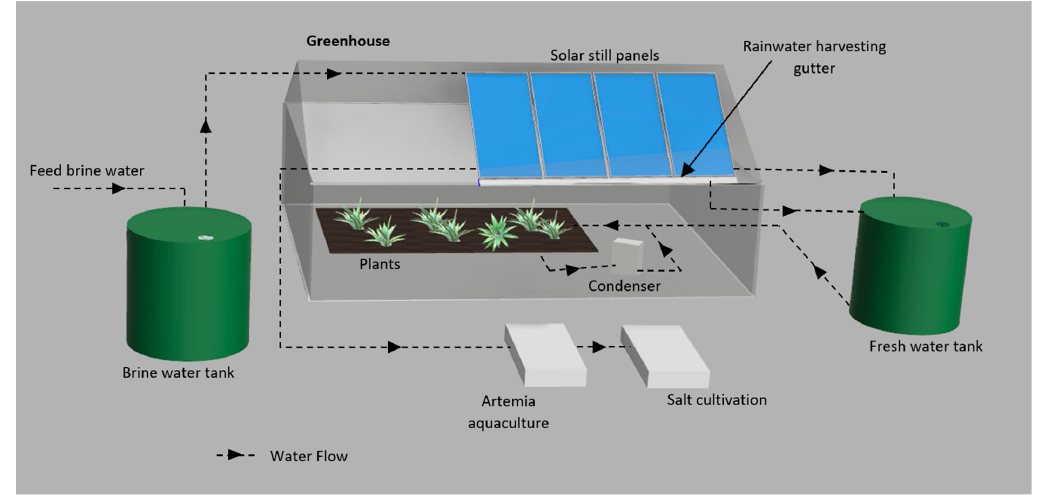
Figure 1. A schematic model of the greenhouse with a zero liquid discharge system.